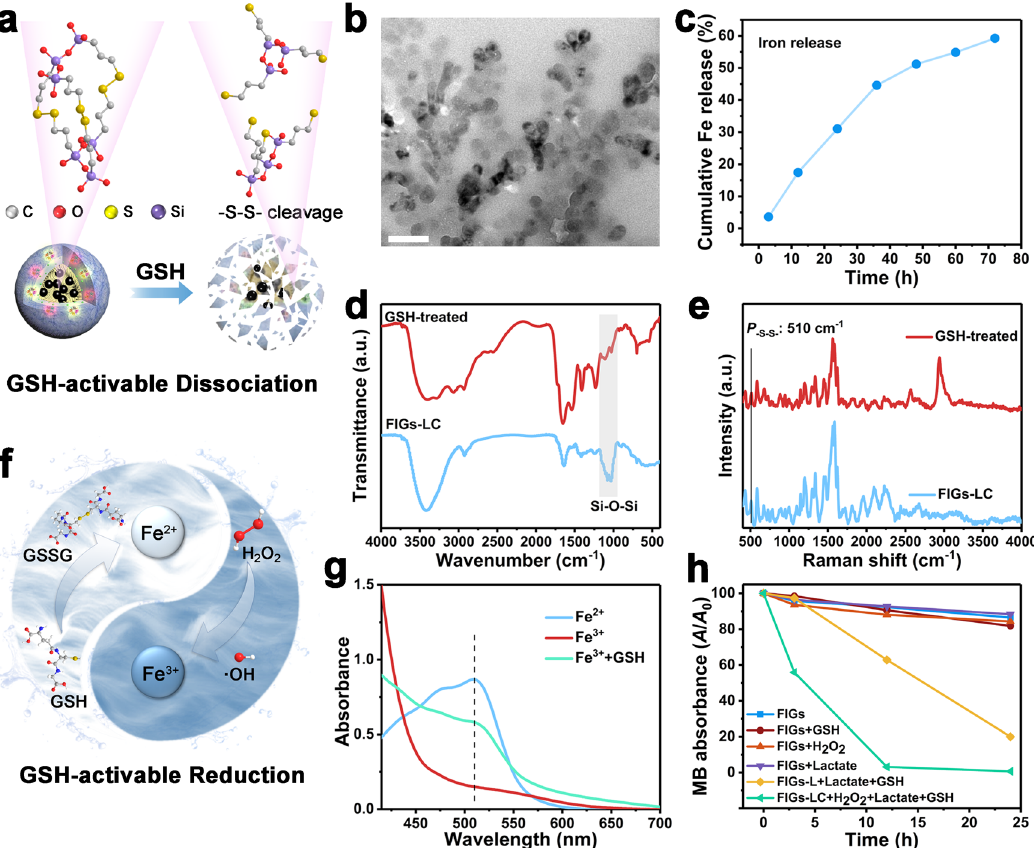
Fig. 3 Responsive behaviors of FIGs-LC to tumor microenvironment. a Schematic of GSH-induced – S – S – cleavage, leading to the collapse of FIGs-LC and iron release. b TEM images of FIGs-LC after a 5-day incubation in the simulated TME solutions (containing 100 μ M of H 2 O 2 , 10 mM of GSH, and 2 mM of lactate, pH 6.0), scale bar:100nm. c Cumulative Fe ions release from FIGs-LC in the simulated TME solutions. d FT-IR spectra of the FIGs-LC and GSH- treated FIGs-LC. e The Raman shift of the FIGs-LC and GSH-treated FIGs-LC. f Schematic cycle of Fe 3 + and Fe 2 + in the tumor microenvironment. g UV-Vis spectra of Fe 2 + solution and Fe 3 + solution after adding 1,10-phenanthroline monohydrate. Specially, the emerging peak at 510 nm indicated the Fe 3 + was converted into Fe 2 + by GSH. h The MB degradation ( A / A 0 ) curves under different